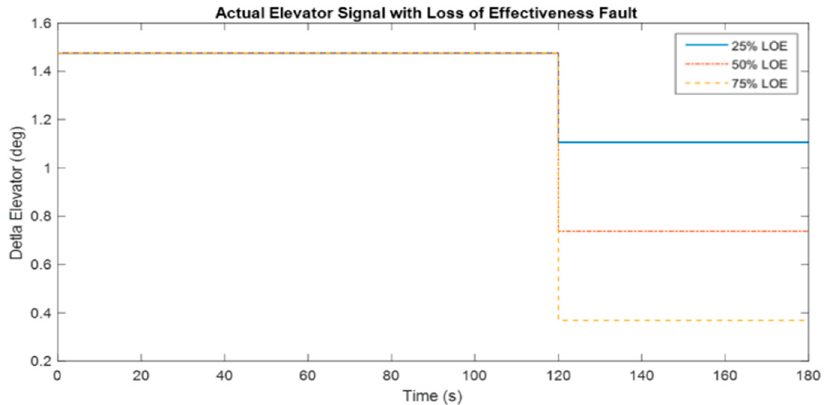
Figure 6. Actual elevator signal with LOE of 25%, 50%, and